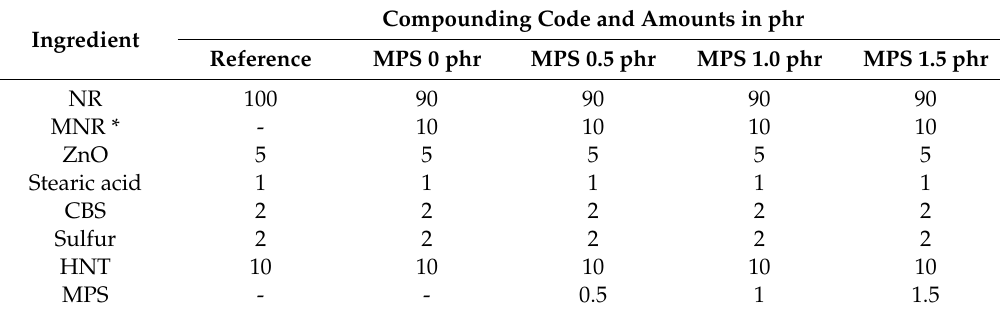
Table 1. Compounding ingredients used to prepare